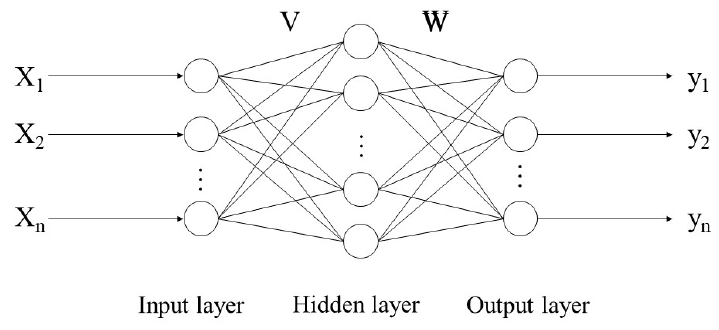
Figure 6. Structure of artificial neural network.